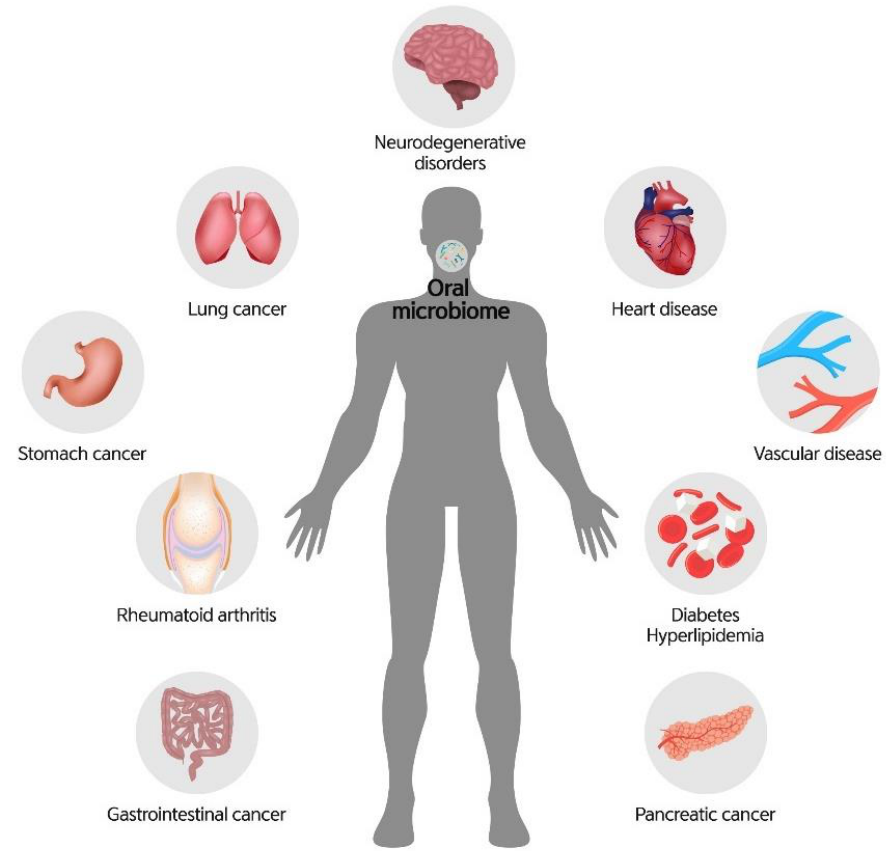
Figure 2. The oral microbiome is a crucial factor for systemic health.